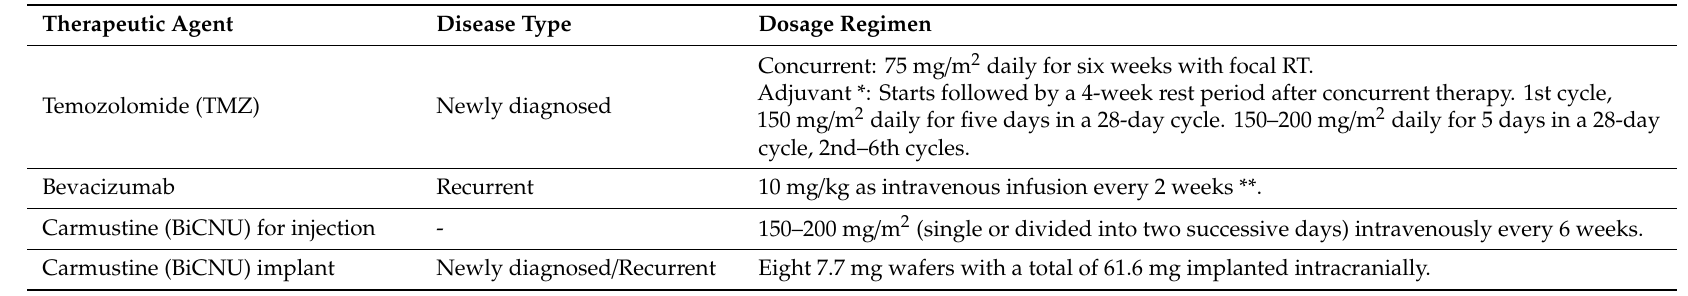
Table 1. Dosage regimen of approved drugs for the treatment of adult glioblastoma. (Source: Dailymed / Food and Drug Administration (FDA) label). RT: